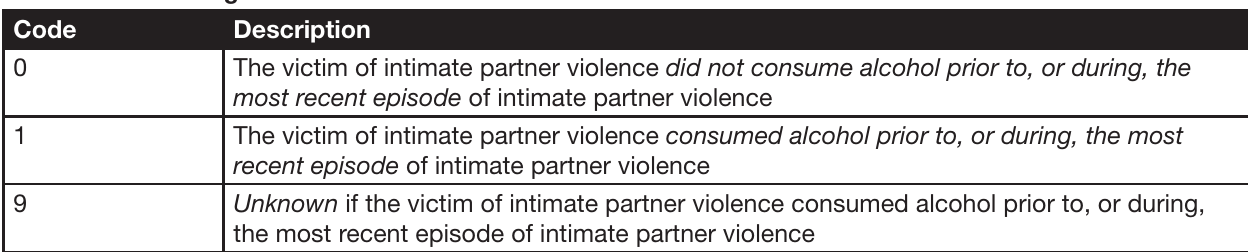
INTIMATE PARTNER VIOLENCE: UNIFORM DEFINITIONS AND RECOMMENDED DATA